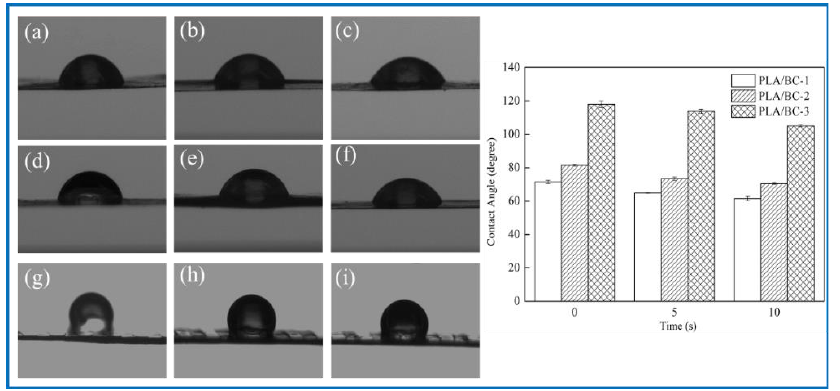
Figure 6. Water contact angle diagram under different contact time: ( a – c ): 0 s, 5 s, 10 s of